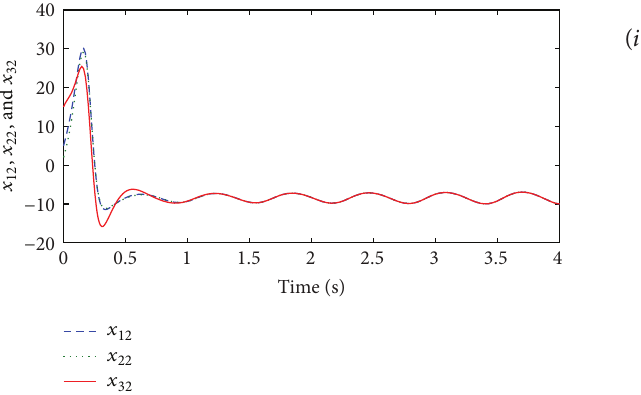
Figure 3: The state trajectories 𝑥 12 , 𝑥 22 , and 𝑥 32 of the Lorenz sys- tems with time 𝑡 .